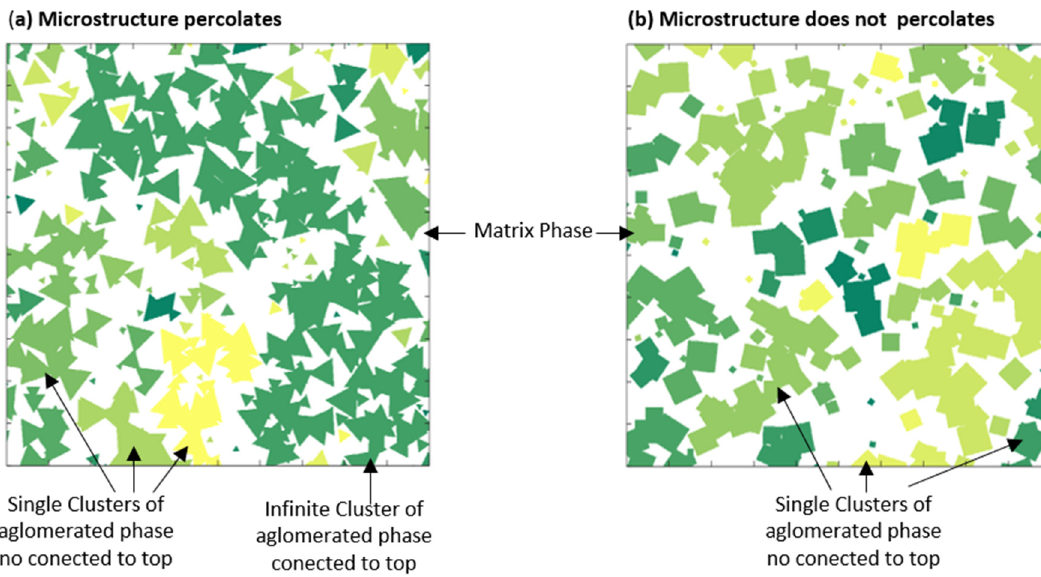
Figure 10. Infinite cluster classification. ( a ) shows different single cluster and an example of infinite cluster when agglomerate phase is connected to top. ( b ) shows single clusters without percolation.